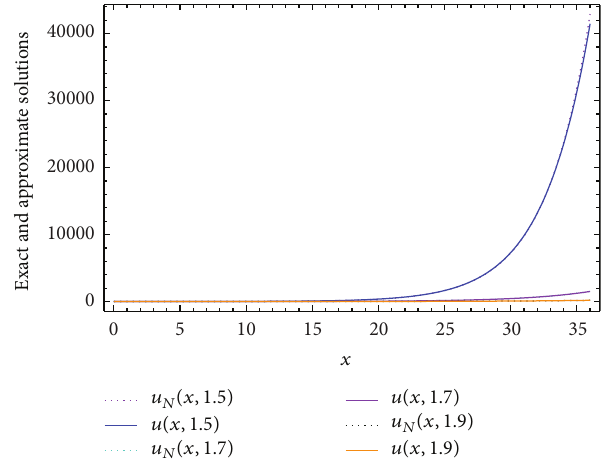
Figure 2: Comparing the exact solution and the approximate solutions at 𝑁 = 10 , 𝛼 = 1 , and ] = 1.5, 1.7, 1.9 .